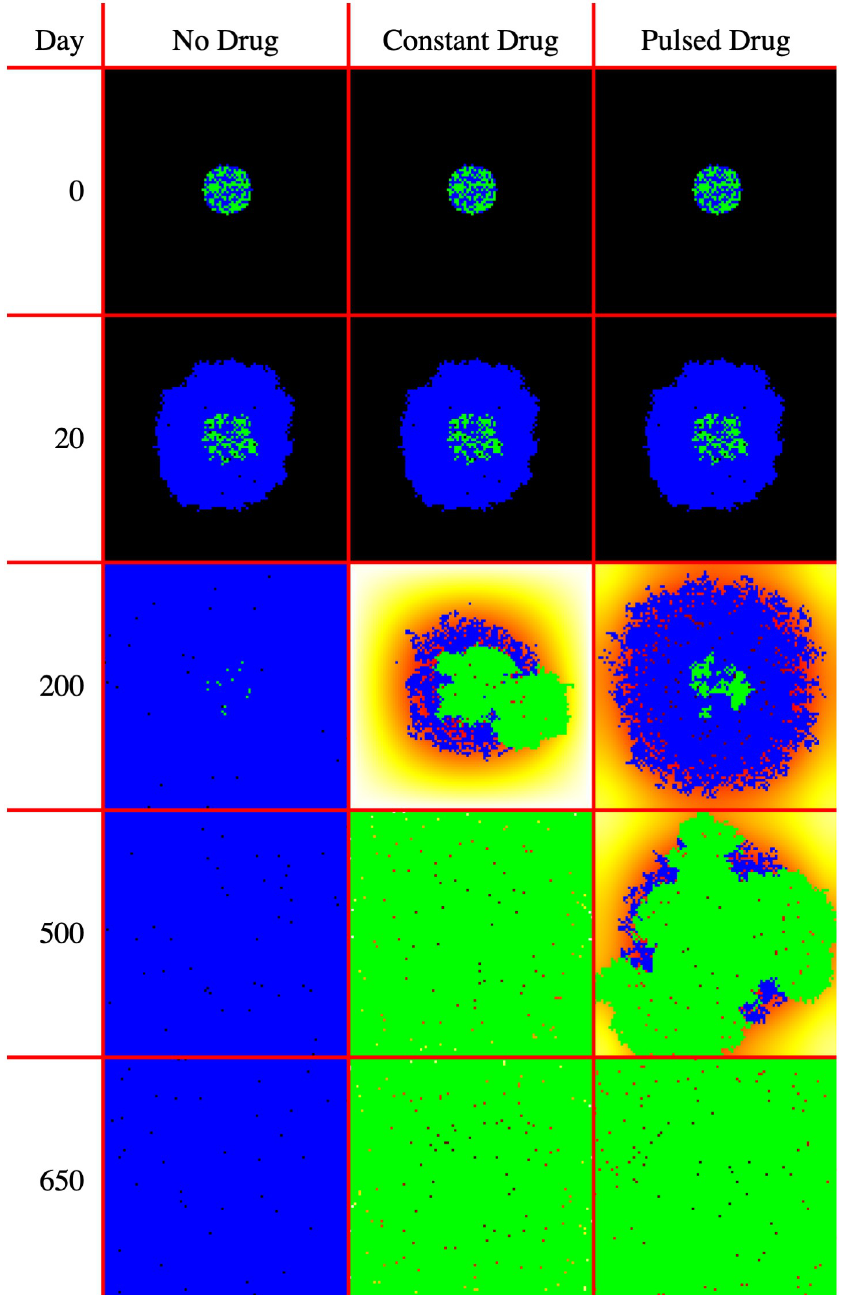
Fig 10. Selected model visualizations. Blue cells are drug sensitive, Green cells are drug resistant, background heatmap colors show drug concentration. The model domain size is 100 by 100 cells, or 4 mm 2